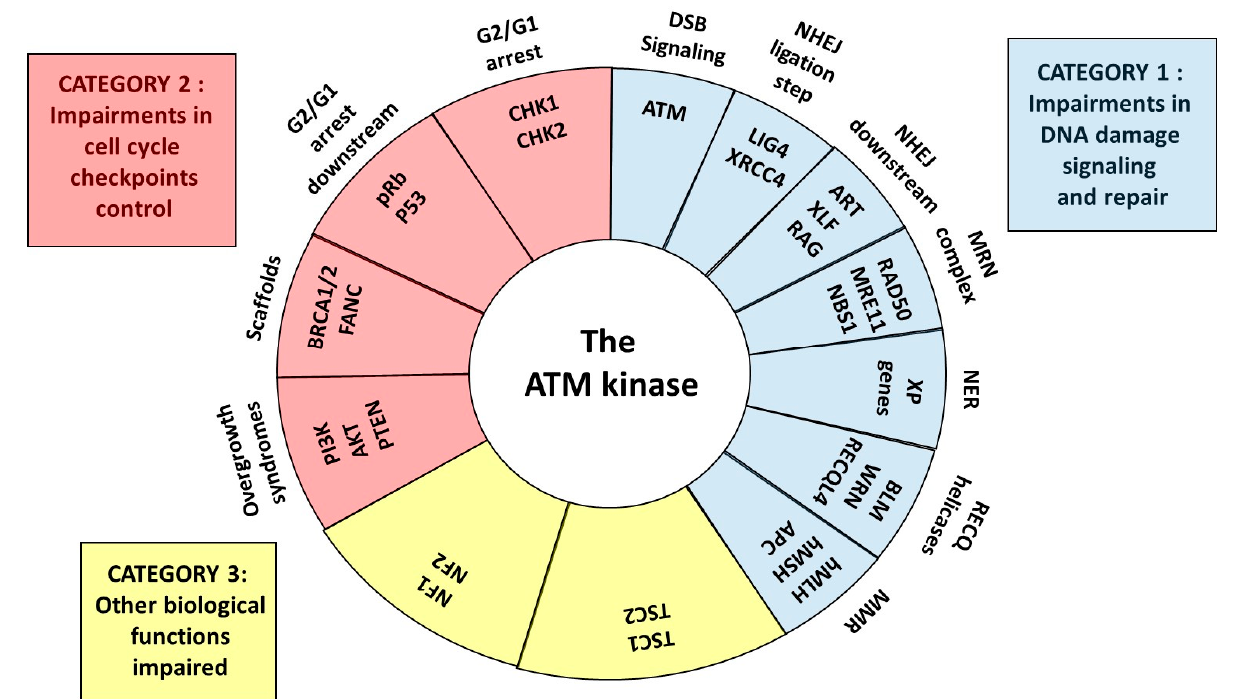
Figure 2. Schematic view of the central role of ATM as a kinase and partner for the proteins whose mutations cause cancer and radiosensitivity syndromes. Three categories can be defined: syndromes due to some impairments in DNA damage signaling and repair, some impairments in cell cycle checkpoint control and to other impaired biological functions.